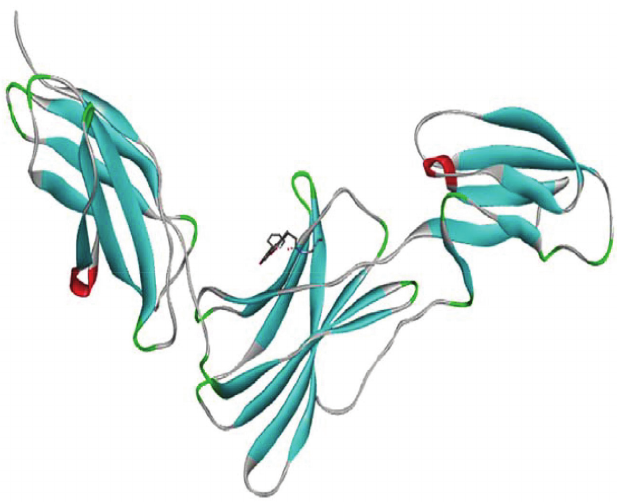
FIGURE 3 - The original crystallographic structure of IL-6R used for the study.